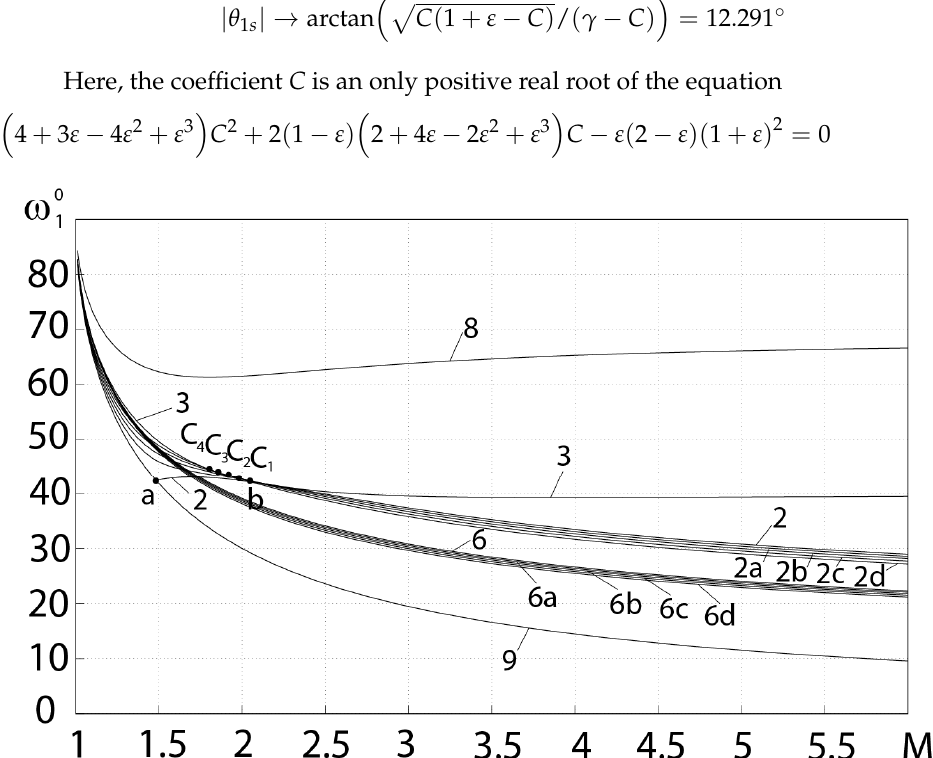
Figure 6. Slope angles of special incident shocks. As in Figures 3 and 5, curve 2 corresponds to von Neumann criterion, curve 3 corresponds to the detachment criterion, curve 6 corresponds to incident shocks forming SMCs at maximum pulsed energy release, and curve 8 corresponds to critical flow velocity after the incident shock. Curve 9 demonstrates the Mach angles. Curves 2a–d and 6a–d describe the variation of incident shock features when the adiabatic index changes at the main shock. Points c 1 – c 4 demonstrate the shift of Mach number M b of coincidence of two basic reflection type criteria.